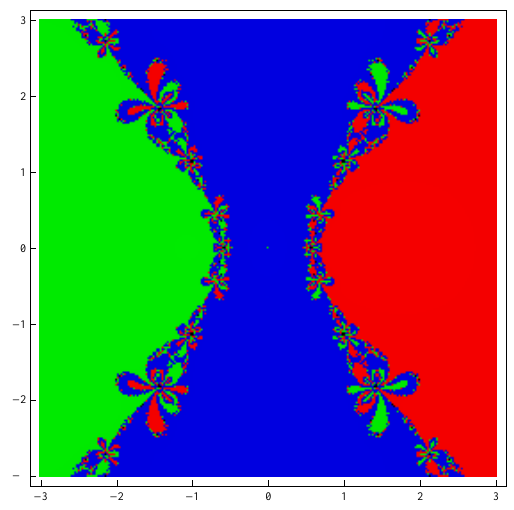
Figure 4. Basins of attraction of method (3) for test problem 2.